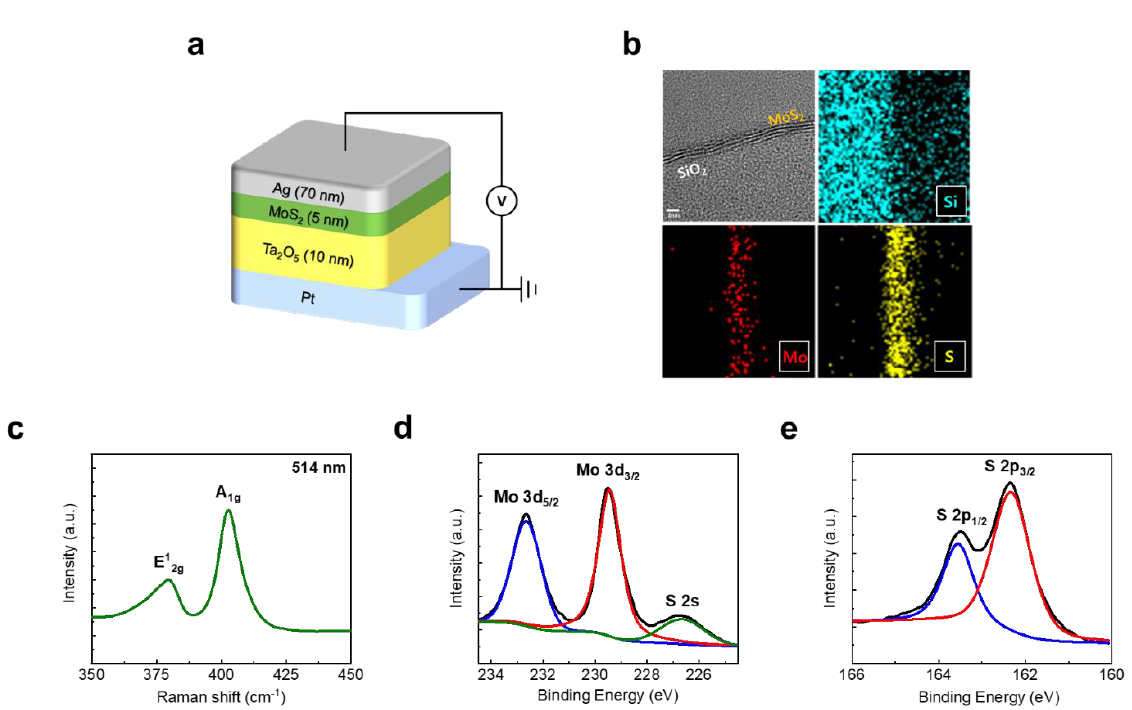
Figure 1. ( a ) Schematic of device structured Pt/Ta 2 O 5 /MoS 2 /Ag. Pt (BE) was grounded and Ag (TE) was applied the voltage. ( b ) The TEM image (top left) and TEM-EDS element mapping image of MoS 2 film on SiO 2 . ( c ) Raman spectrum of in situ grown MoS 2 film. ( d , e ) XPS spectrum of MoS 2 film and Mo 3D peaks and S 2p peaks, respectively.